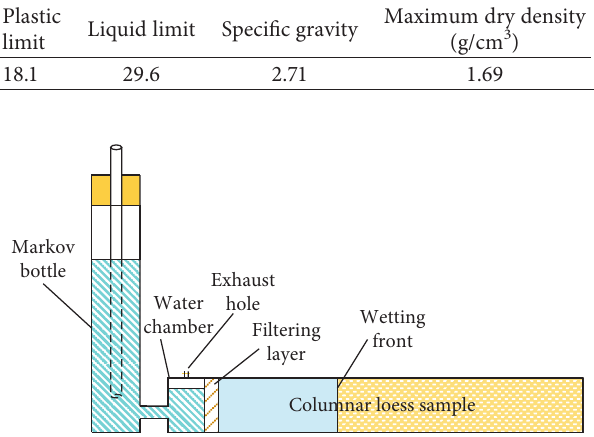
Figure 1: Experimental apparatus for water